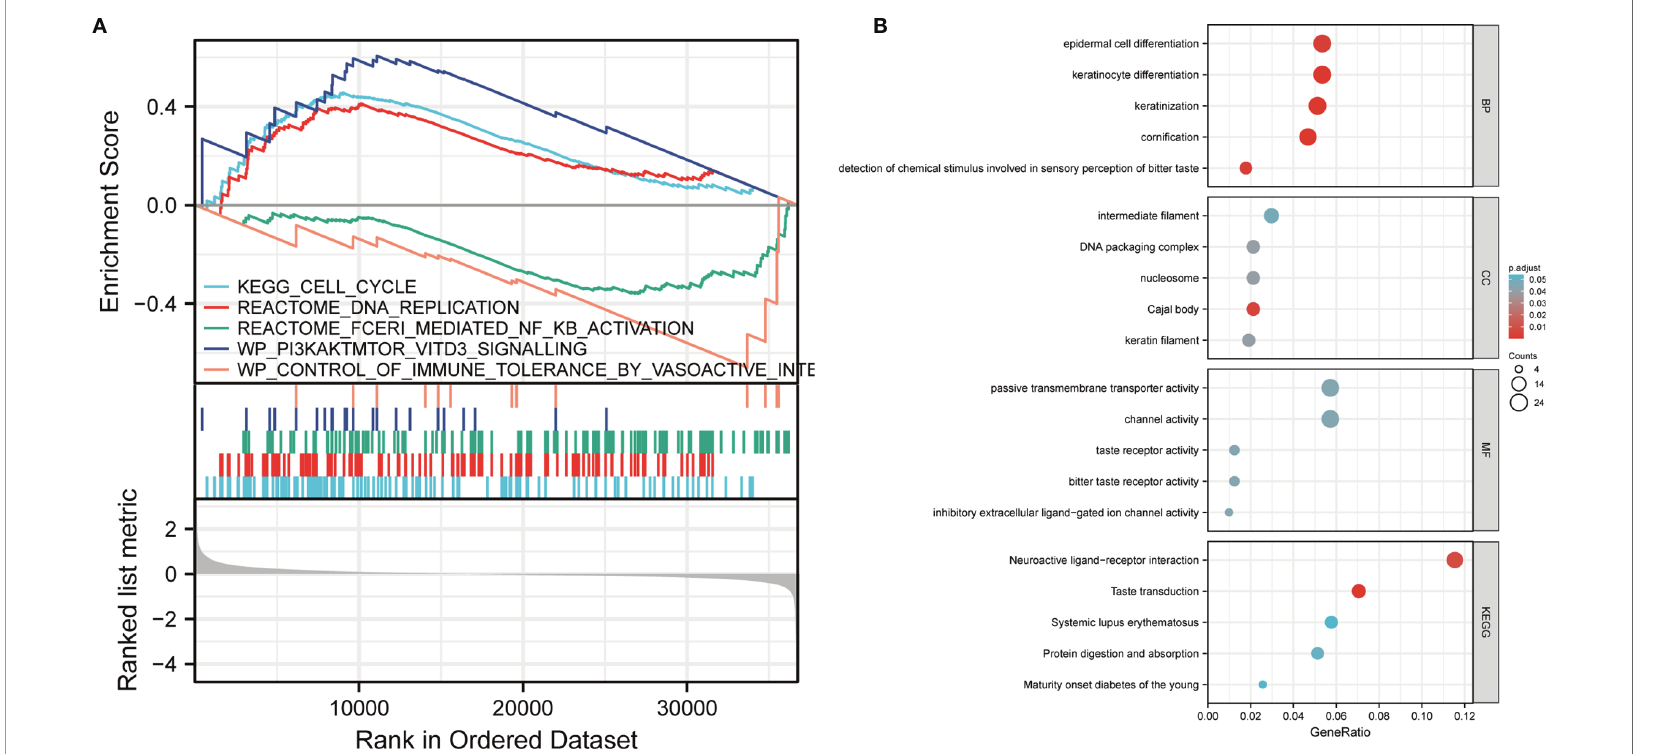
FIGURE 3 | GSEA analysis results. (A) Genes enriched in representative pathways were analyzed by GSEA function. (B) GO and KEGG analysis of DEGs in low and high expression samples of